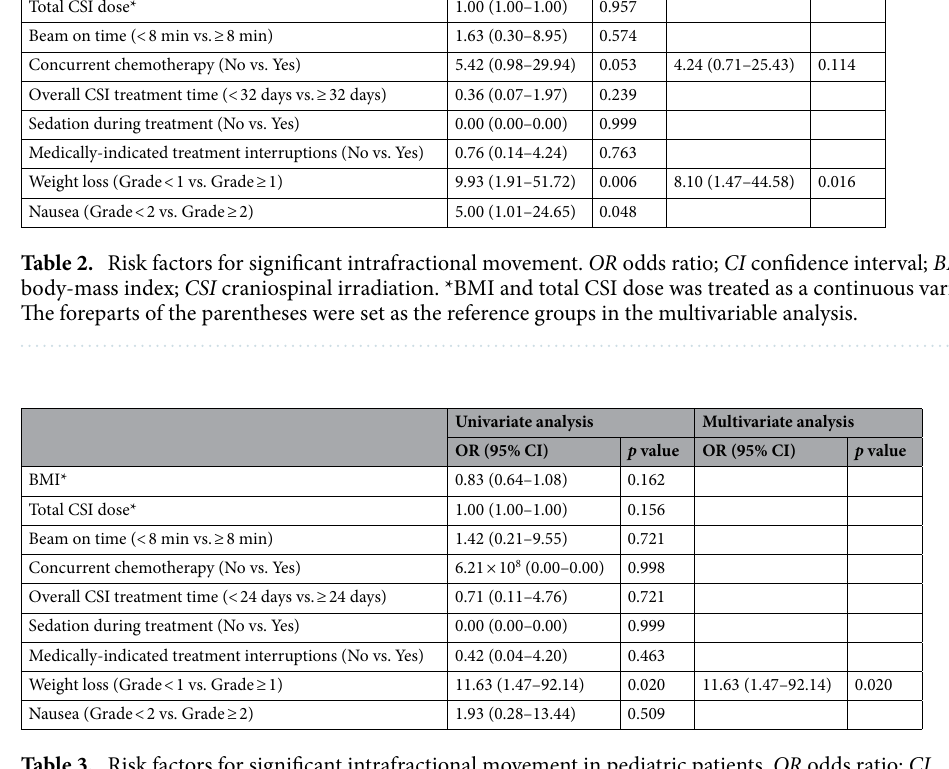
Table 3. Risk factors for significant intrafractional movement in pediatric patients. OR odds ratio; CI confidence interval; BMI body-mass index; CSI craniospinal irradiation. *BMI and total CSI dose was treated as a continuous variable. The foreparts of the parentheses were set as the reference groups in the multivariable